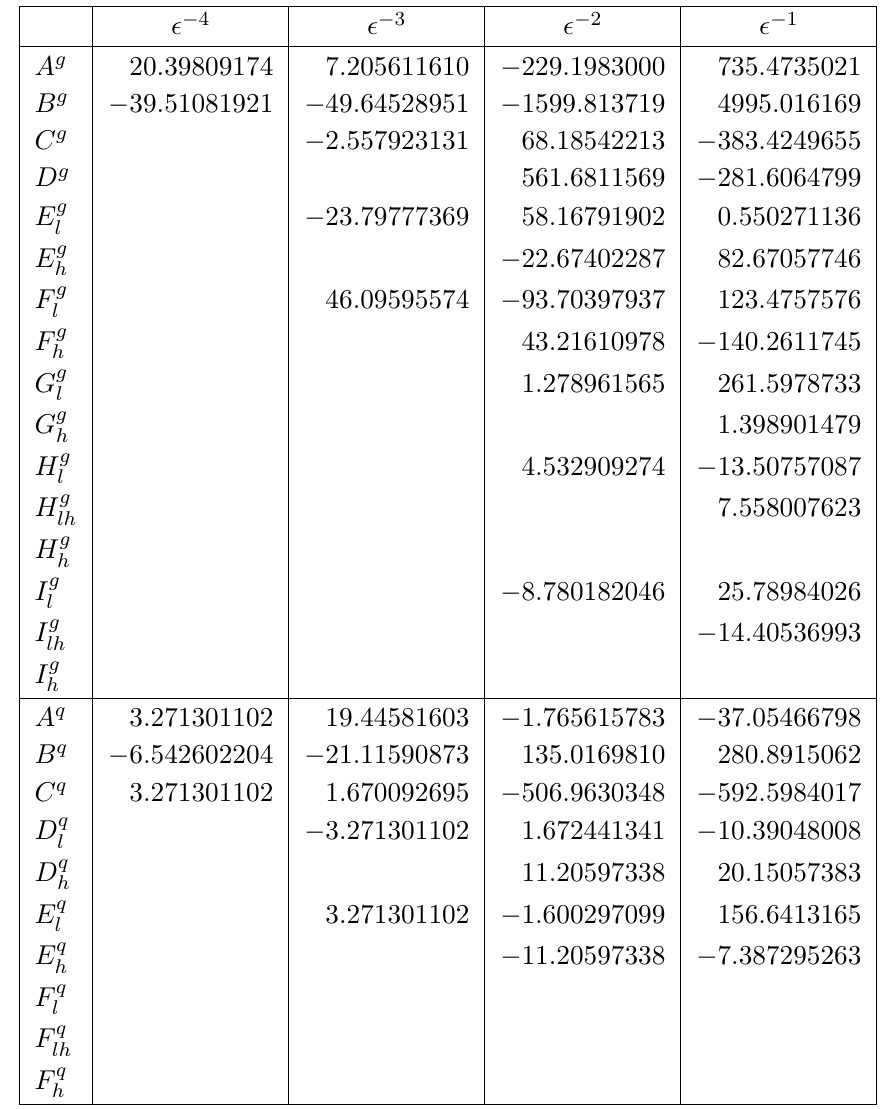
Table 4 . IR poles decomposed as color coefficients for the phase-space point x 12 = 3249 / 400